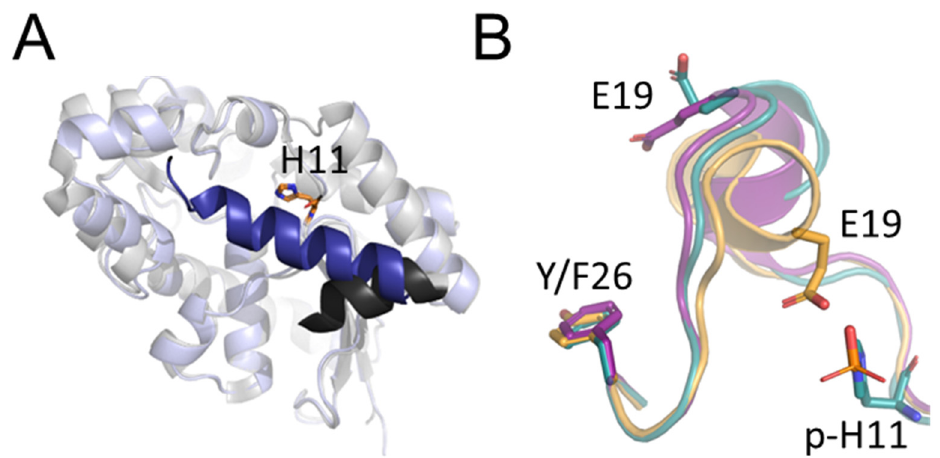
Figure 2. Structure of PGAM2 compared with PGAM1 and Alpha Fold prediction. ( A ) Superposition of rabbit PGAM2 crystal structure (gray) and Alpha Fold prediction of human PGAM2 structure (blue). C-terminal region in disagreement with prediction is highlighted in darker colors. Catalytic H11 residue in orange. ( B ) Difference in position of E19 in PGAM2 (purple), dephosphorylated PGAM1 (orange, PDB ID 4GPI) and phosphorylated PGAM1 (cyan, PDB ID 4GPZ).